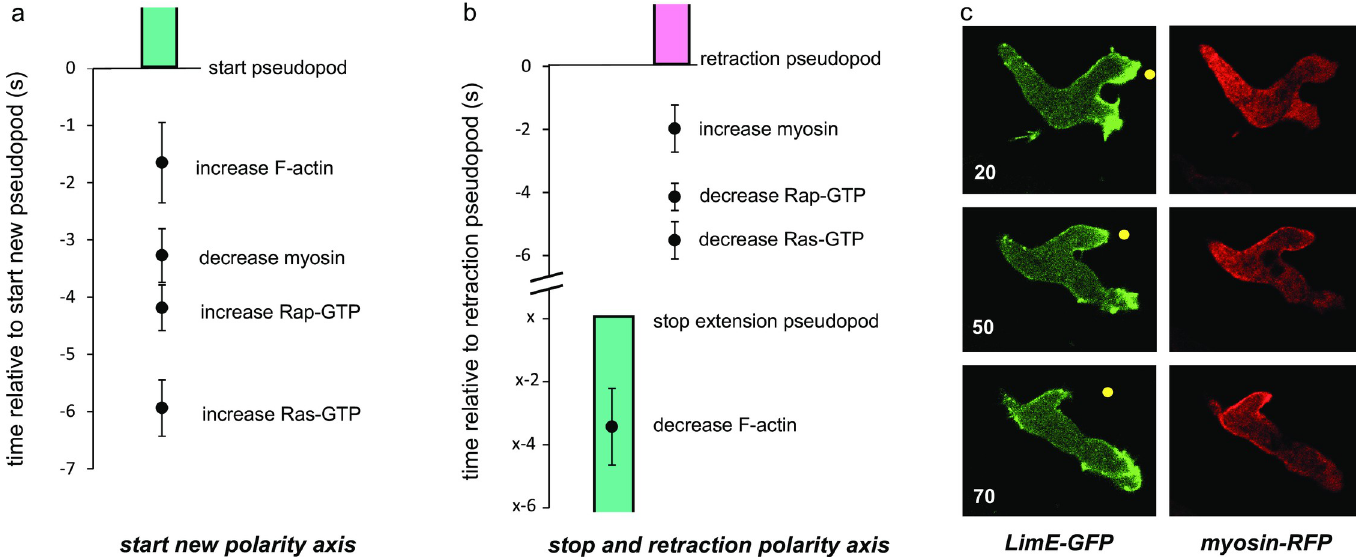
Fig 6. Kinetics of signaling molecules in pseudopods of a new or a retracting polarity axis. Wild type AX3 cells expressing different markers were analyzed. a. Cells begin to extend a de novo pseudopod at the side of the cell forming a new polarity axis. Time t = 0 is the start of the pseudopod. Indicated are the times at which the sensors for the indicated signaling molecules begin to increase or decrease at the place where the pseudopod later begins. Data are means and SEM of 8 determinations. b. Cells with two extending pseudopods retract one pseudopod. The extension of one pseudopod stops at time t = x and retraction begins at t = 0s. The value of x, is very variable, between 4 and 20 s, but in all cases F-actin declines about 3 s before the pseudopod stops. Data are means and SEM of 10 determinations. c. Images of a cell expressing LimE-GFP (detecting F-actin) and myosin-RFP that retracts the upper pseudopod. The yellow dot is at identical positions in the three images. The upper pseudopod begins retraction at